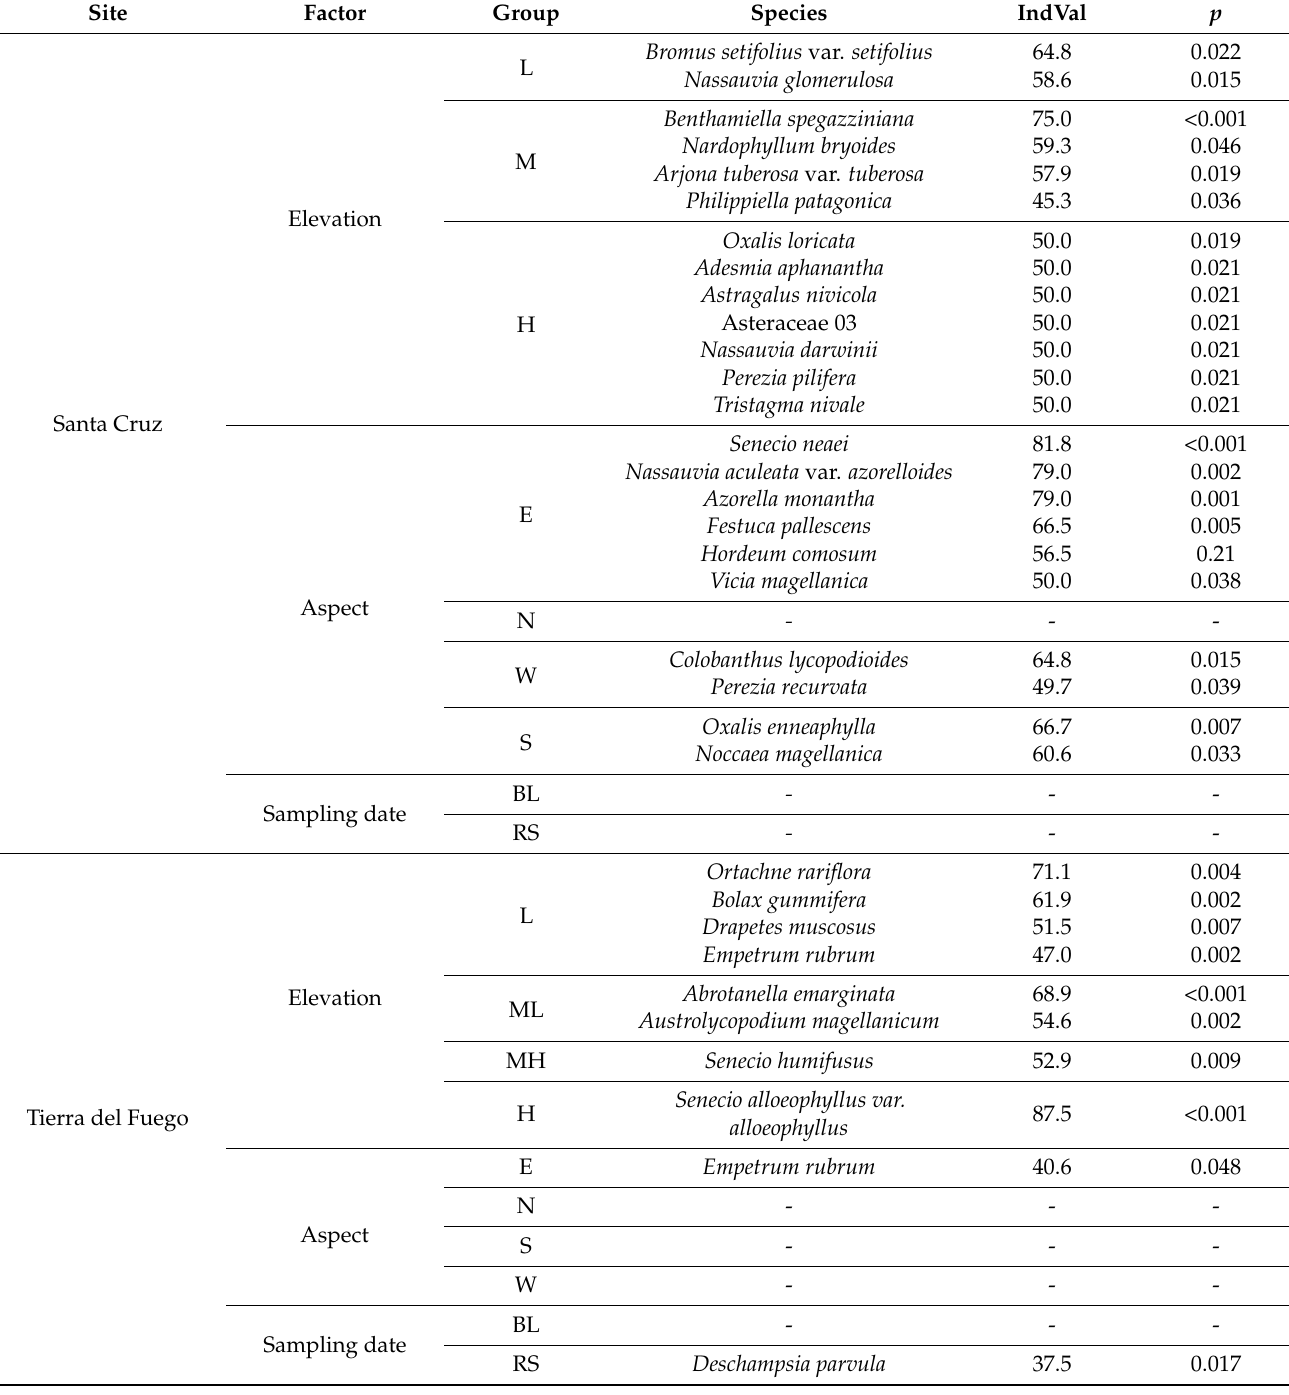
Table 4. Indicator Value analysis results showing indicator value (IndVal, %) and probability ( p ) for the studied alpine vascular plant species in South Patagonia mountain sites, immersed in grassland (Santa Cruz) or forest (Tierra del Fuego) landscapes, according to groups defined by elevation (L = low, M = medium, ML = medium-low, MH = medium-high, H = high), cardinal aspect (N = north, E = east, S = south, W = west), and sampling date (BL = baseline, RS =